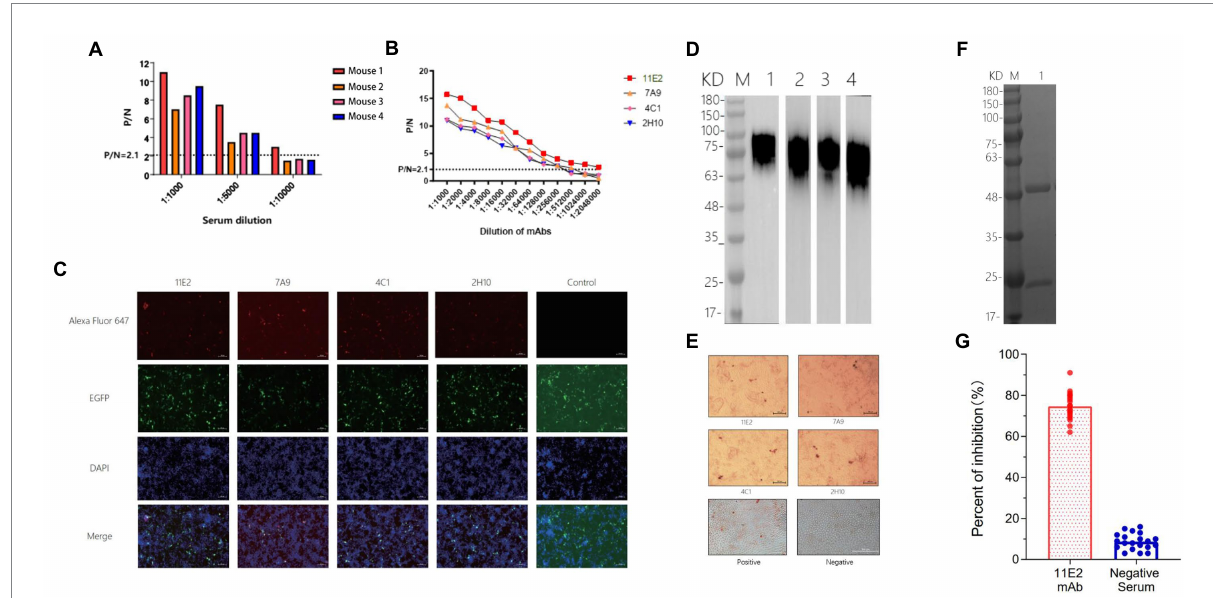
FIGURE 4 Characterization and identification of mAbs. (A) Determination of the serum titer of the mice before hyperimmunization by indirect ELISA. (B) Determination of the mAb titers. A P/G value greater than or equal to 2.1 is considered positive, and the corresponding maximum dilution is the titer of serum or mAbs. (C) Four mAbs were identified by IFA. The CD2v recombinant protein gene was linked to a vector containing the EGFP label and was transfected into 293 T cells. A monoclonal antibody was used as the primary antibody, and a goat anti-mouse Alexa Fluor 647 fluorescent antibody was used as the secondary antibody to display red fluorescence. DAPI was used as the nuclear staining fluid. The control group was used as a negative control. (D) Four mAbs were identified with CD2v recombinant protein by a western blot assay. M represents the protein marker, monoclonal antibody 11E2 was incubated in Lane 1, Lane 2 is 7A9, Lane 3 is 4C1 and Lane 4 is 2H10. (E) The reactivity of the mAbs with ASFV HLJ/18 strain. Scale bars, 200 μ m. (F) SDS–PAGE analysis of purified monoclonal antibody 11E2. (G) CD2v mAbs evaluation by the